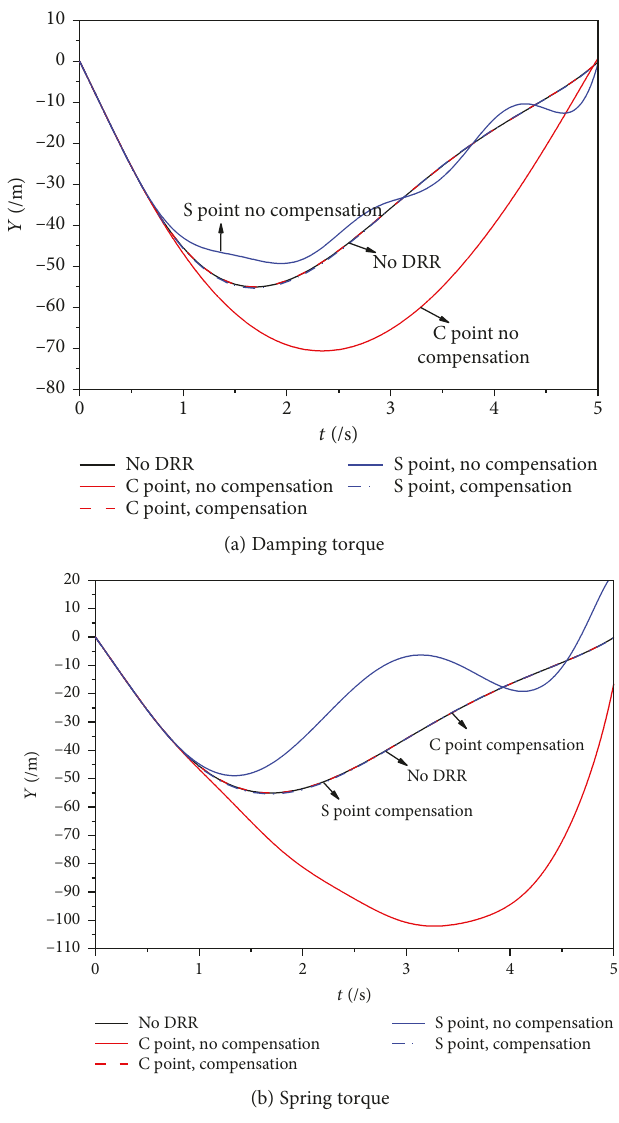
Figure 16: Trajectory